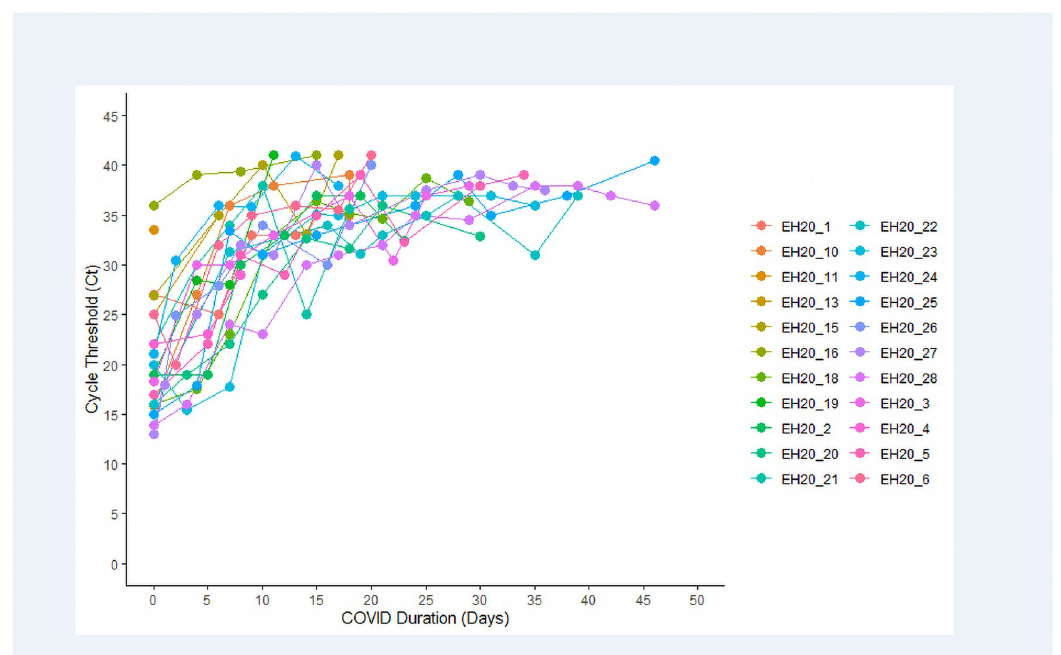
Fig 1. Viral load evolution for each patient. Cycle count, measured in samples collected every 3–5 days from first positive RT-PCR test to first of two negative RT-PCR tests, in patients with complete data.